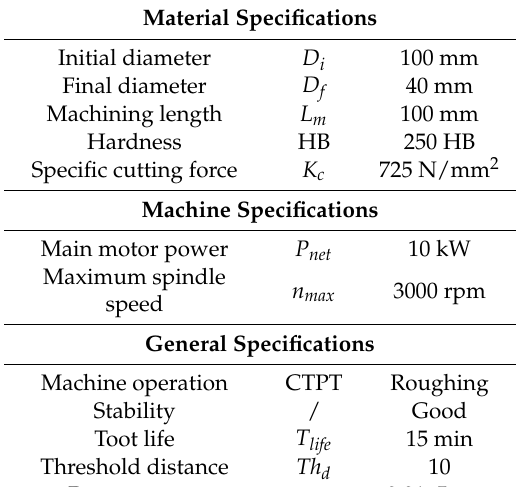
Table 12. Working specifications of the heavy roughing operation example.